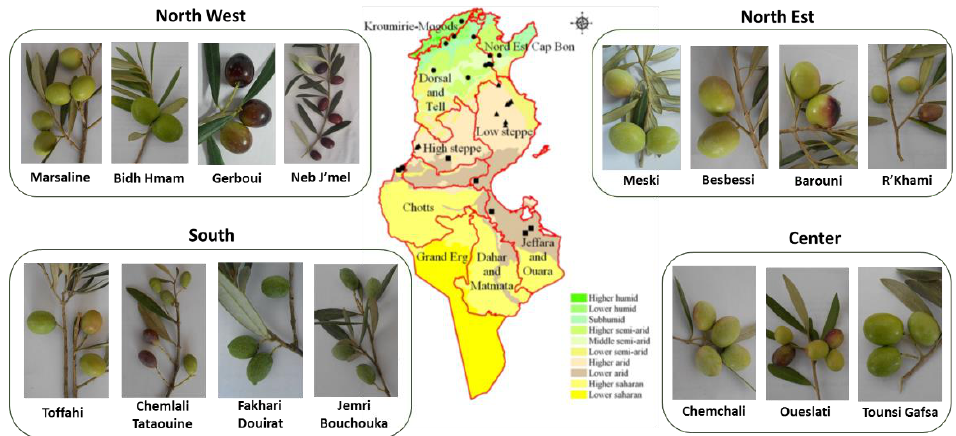
Figure 1. Diversity of some olive varieties cultivated in different areas of Tunisia (Photograhs of F. Ben Amar, Olive Tree Institute).